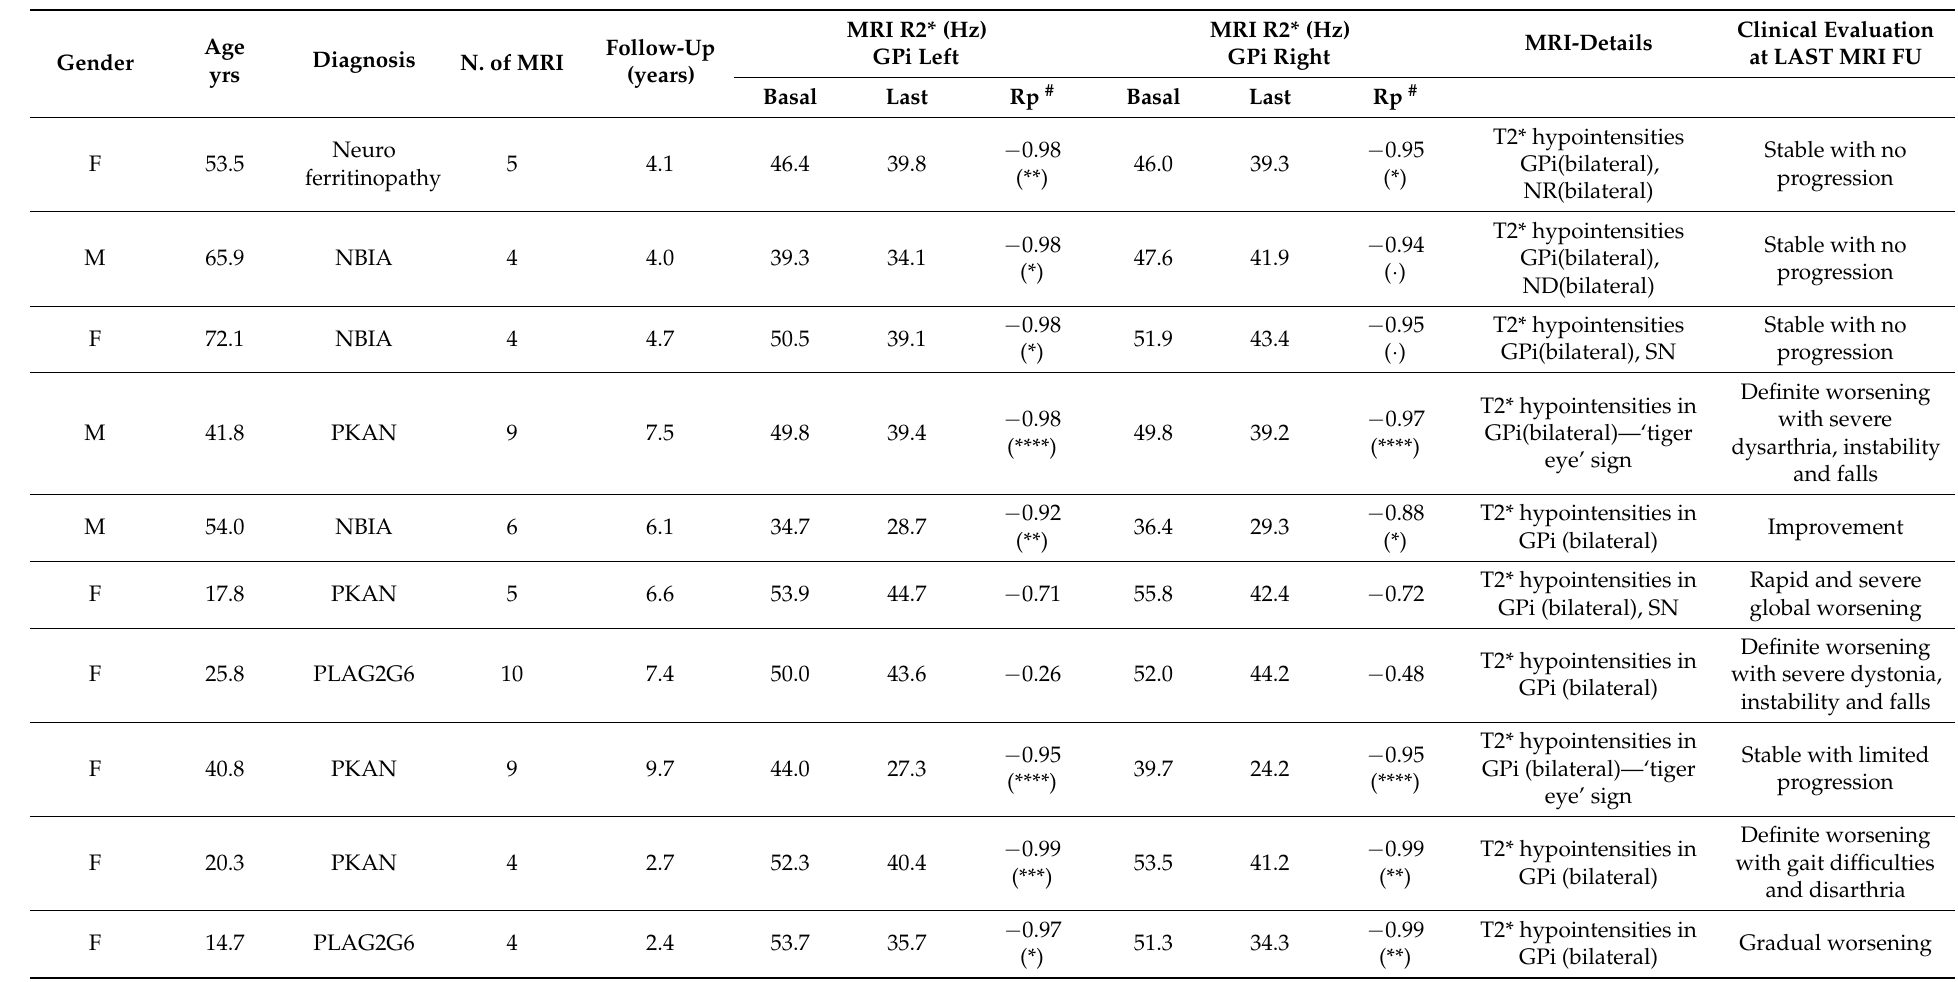
Table 1. Clinical and diagnostic